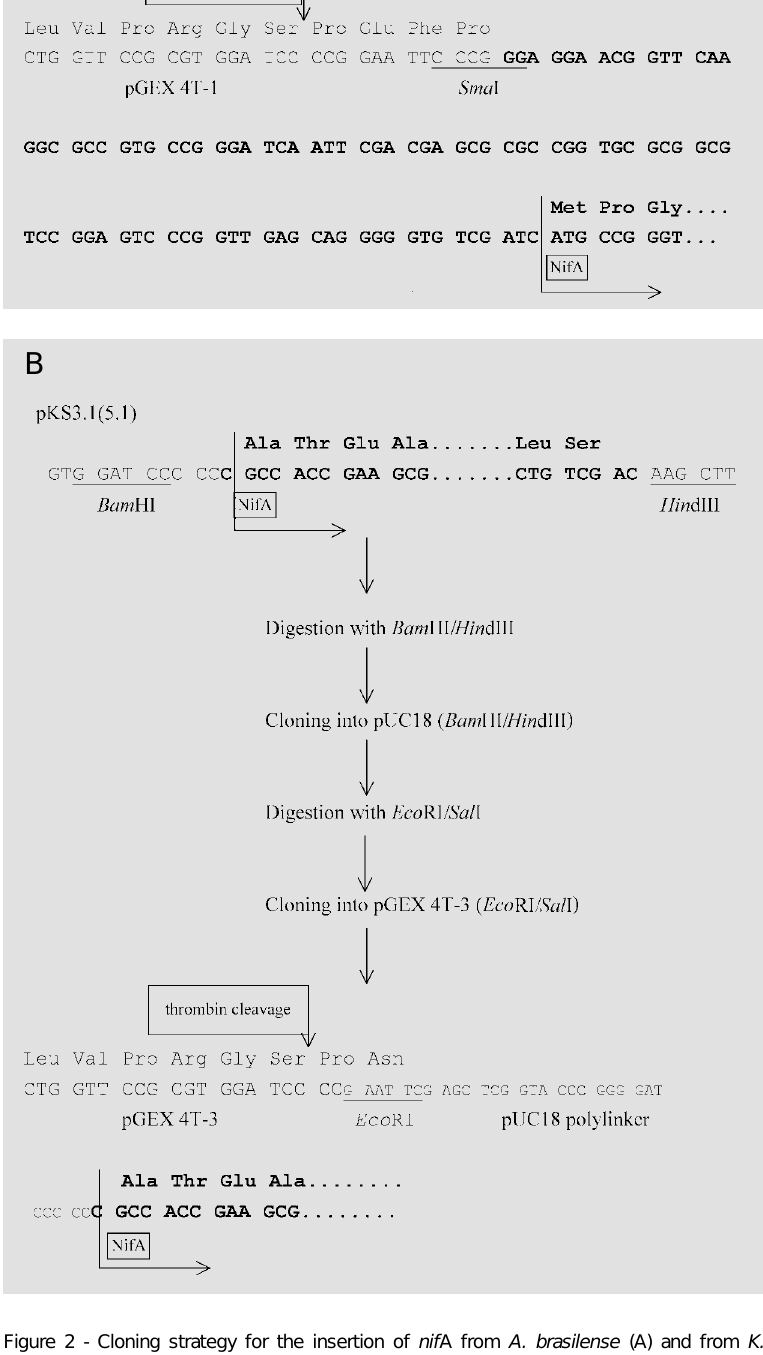
Figure 2 - Cloning strategy for the insertion of nif A from A. brasilense (A) and from K. pneumoniae (B) into the pGEX 4T vector. The nucleotide sequence from the nif A gene is indicated in bold type. The first amino acids for the coding region of NifA are indicated in bold above the nucleotide sequence. Small capital letters represent the pUC18 polylinker. The region that represents the nif A gene/NifA protein is marked by an